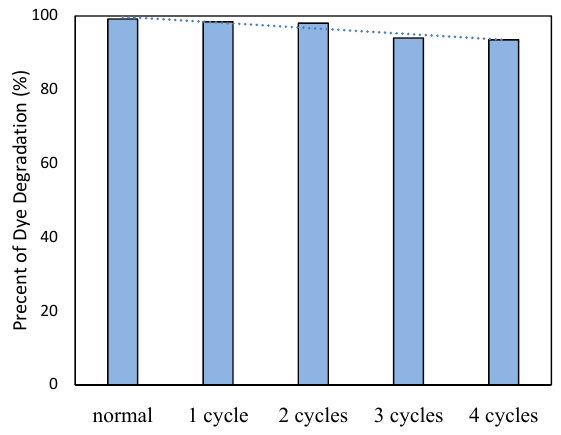
Fig. 18. Reusability of TiO 2 /Fe 3 O 4 /MWCNT in 5 consecutive cycles Nanocomposite dosage = 0.5 g/L, dye concentration = 50 ppm, DO = 7/4 mg/L, pH= 7) (